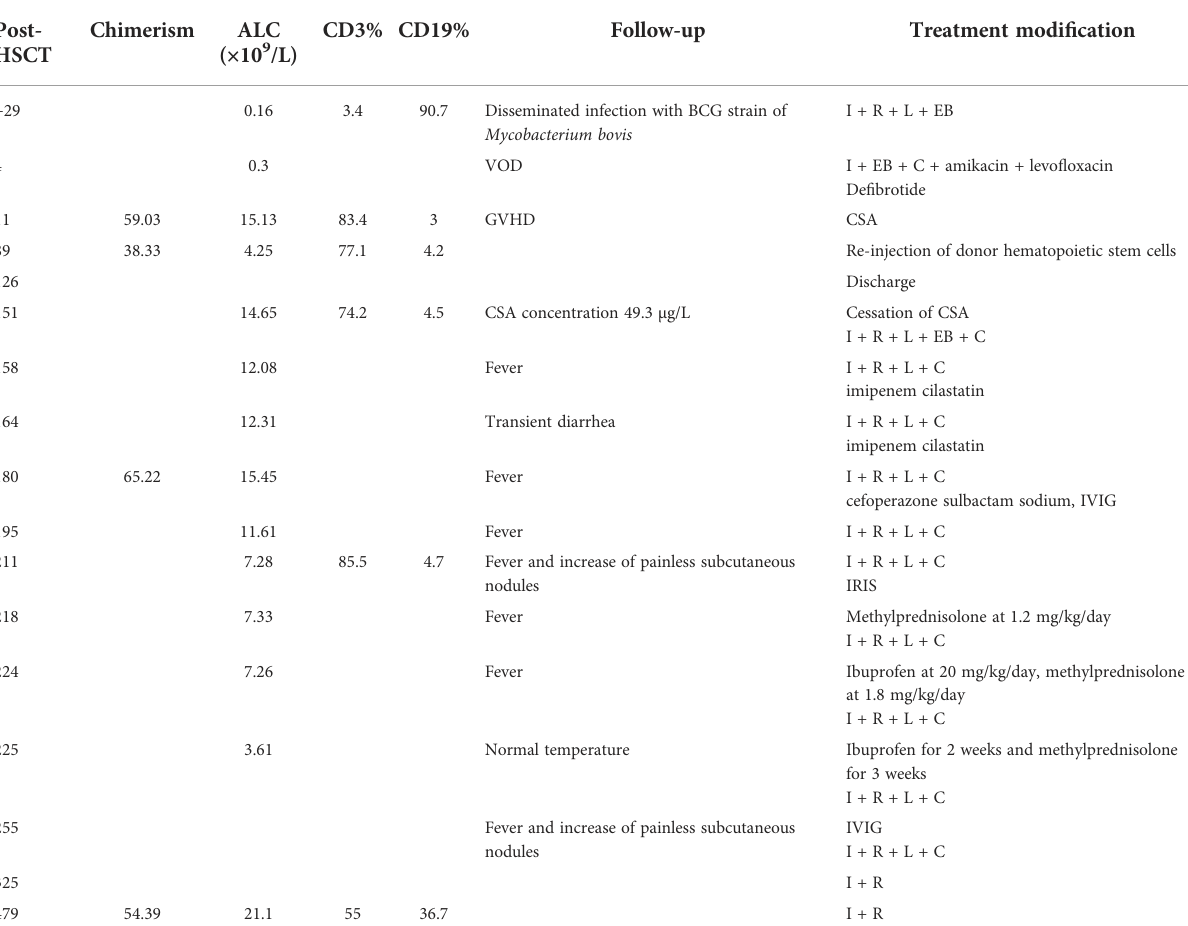
TABLE 1 List of major episodes.